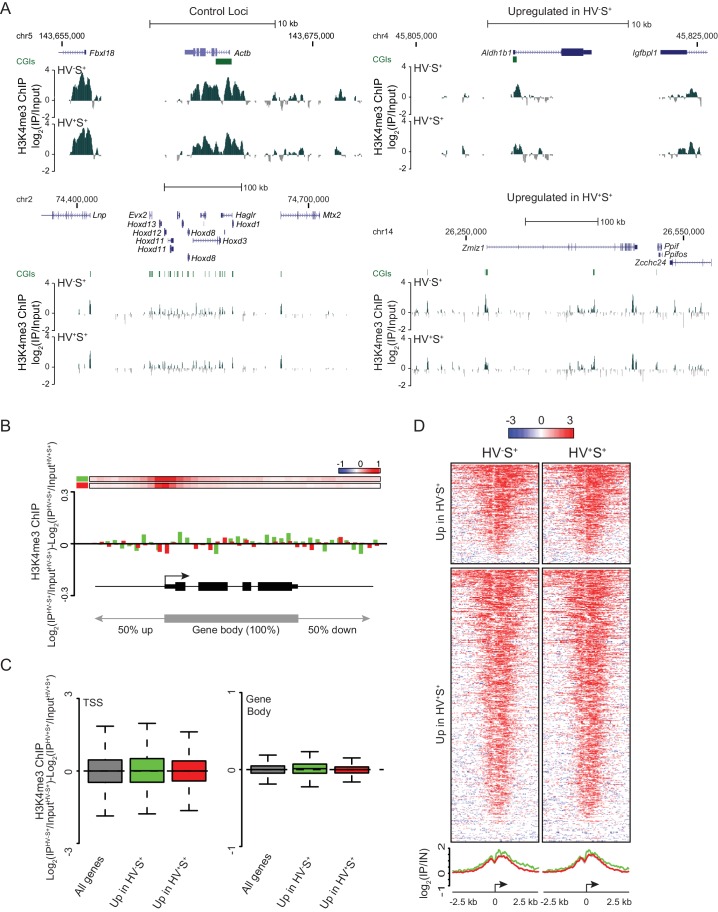
Invariant H3K4me3 levels at Epi- and PrEn-primed genes.(A) Example H3K4me3 ChIP-seq profiles (log2(IP/Input)) for Actb and Hoxd (control), Aldh1b1 (upregulated in HV-S+) and Zmiz1 (upregulated in HV+S+). Profiles were generated using the UCSC genome browser with coordinates given for mm9. (B) H3K4me3 ratios (log2(IPHV-S+/InputHV-S+)-log2(IPHV+S+/InputHV+S+)) between the HV-S+ and HV+S+ populations across a composite gene with normalized length representing genes upregulated in HV-S+ (green) and HV+S+ (red). The bars at the top represent mean read depth of both populations across the locus. (C) Boxplots showing the ratio of H3K4me3 ChIP-seq signal between HV-S+ and HV+S+ ESC populations for TSS (left; ± 500 bp) and gene body (right) for all genes (grey), genes upregulated in HV-S+ (green) and genes upregulated in HV+S+ (red). (D) Heatmaps and summary plots of H3K4me3 (log2 (IP/Input)) around the TSS (± 2.5 kb) for differentially expressed gene sets in both the HV-S+ and HV+S+ ESC populations.